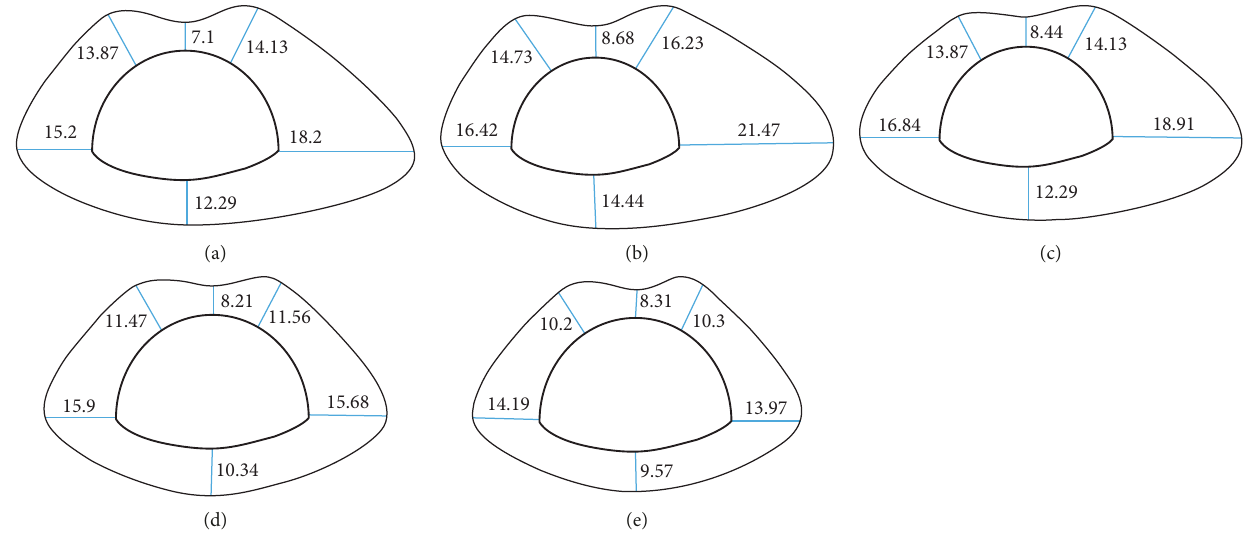
Figure 14: The distribution of the deviatoric stress under different slope coefficients at a rock inclination angle of 30 ° . (a) Before. (b) ω � 3. (c) ω � 4. (d) ω � 5. (e) ω � 6.